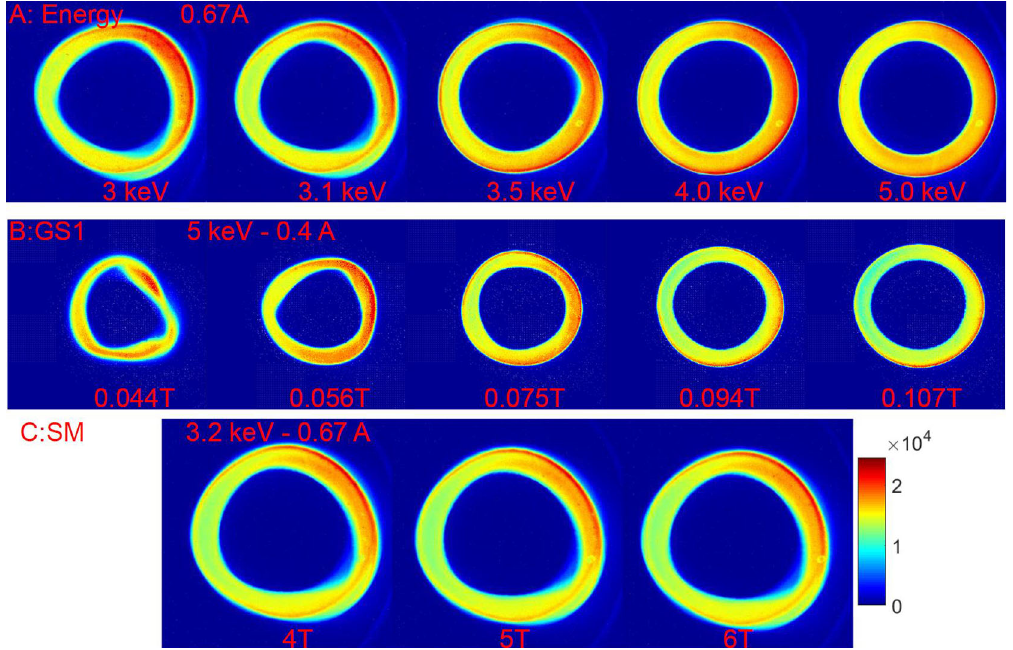
FIG. 5. Measured hollow beam profiles with different electron beam energy (a), GS1 magnetic field (b), and superconducting solenoid magnetic field (c). The color scale represents the relative intensity of the pixels with arbitrary